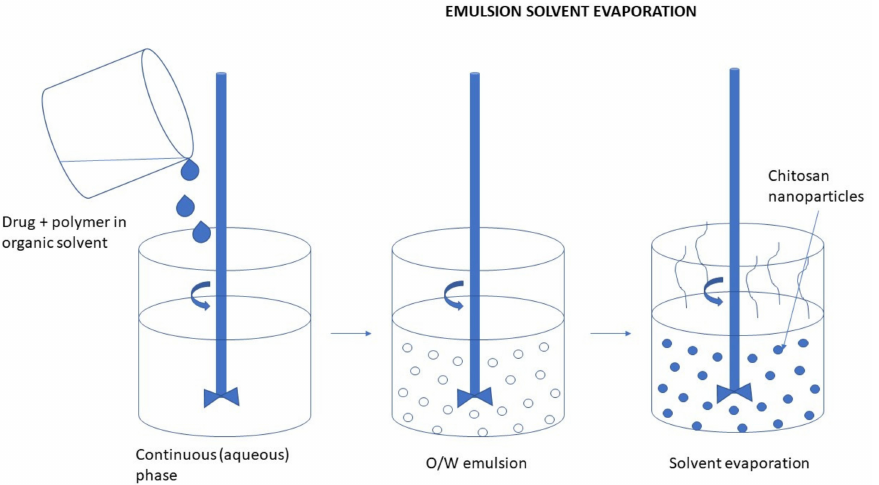
Figure 7. Preparation of CS NPs by the emulsion solvent evaporation